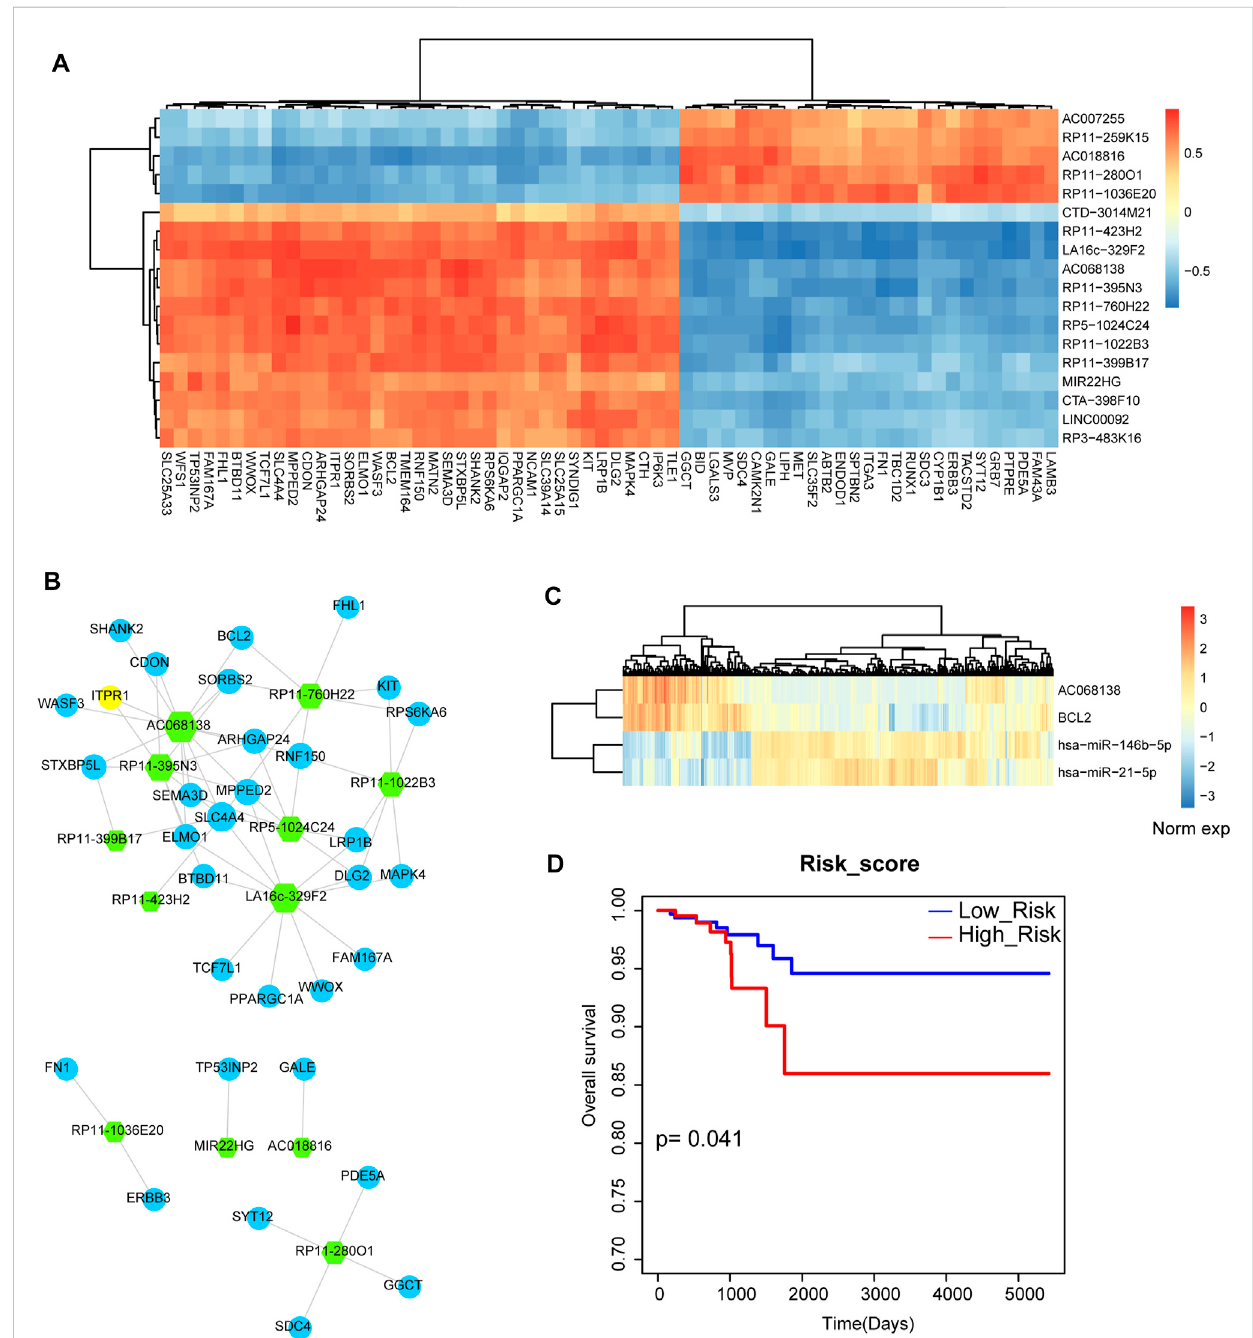
FIGURE 5 AnalysisoflncRNA-mRNAnetworkandlncRNA-miRNA-mRNAcrosstalk. (A) TheheatmapofcorrelationsbetweenlncRNAsandmRNAsthatshared at least one common miRNA. (B) The thyroid cancer-related lncRNA-mRNA ceRNA network. Green hexagon represents lncRNA and blue circular representsmRNA.Nodesizerepresentsdegreeofnode. (C) Theheatmapoftheexpressionof AC068138 , BCL2 , miR-146 and miR-21 . (D) AKaplan-Meier survival curve of the combination of AC068138 , BCL2 , miR-146 and miR-21